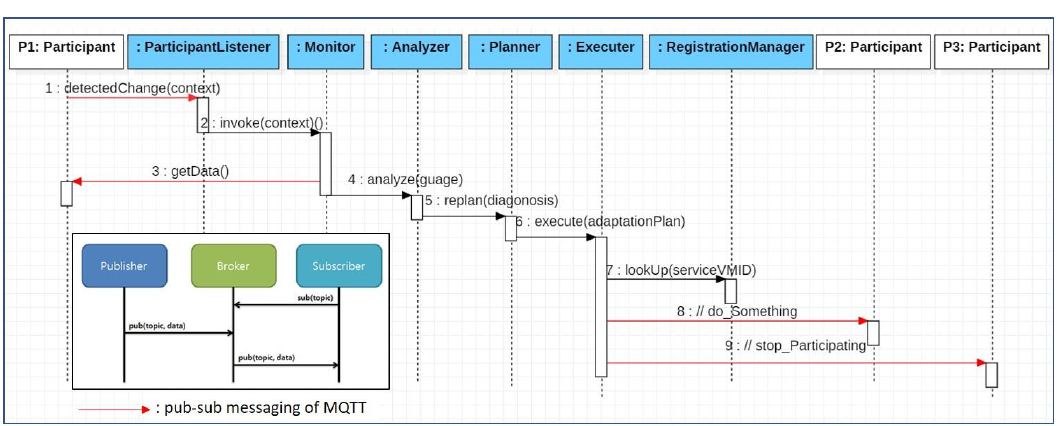
Figure 3. Provided pattern for communication between participants and Virtual Machine (VM) in cloud.